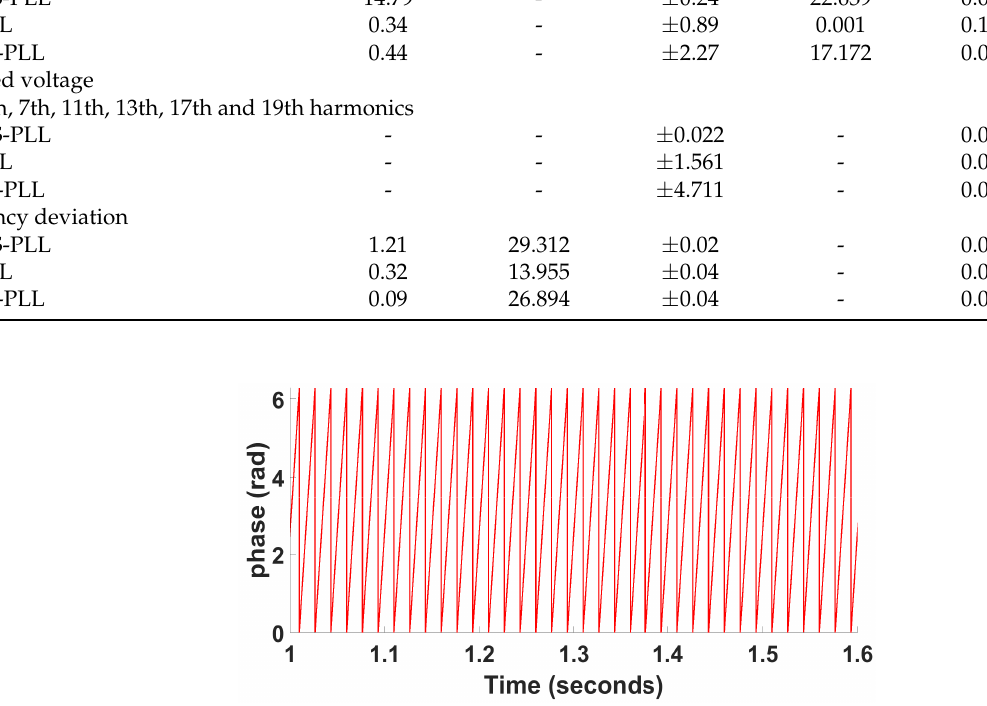
Figure 7. Grid position during unbalanced grid voltage sag in two phases.